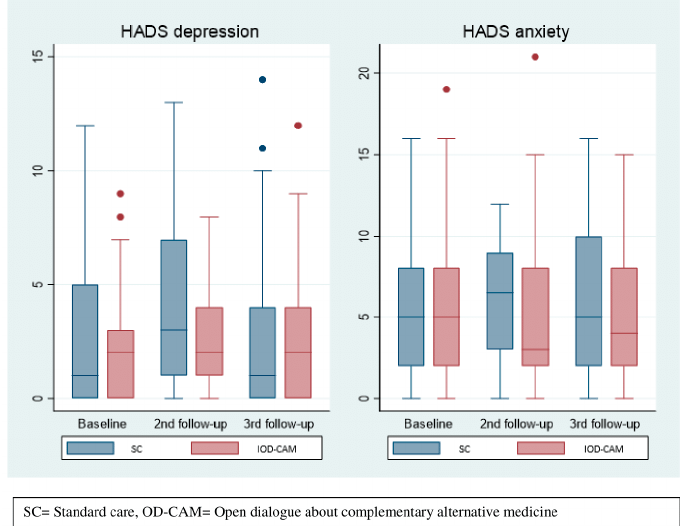
Figure 3. Depression and anxiety.